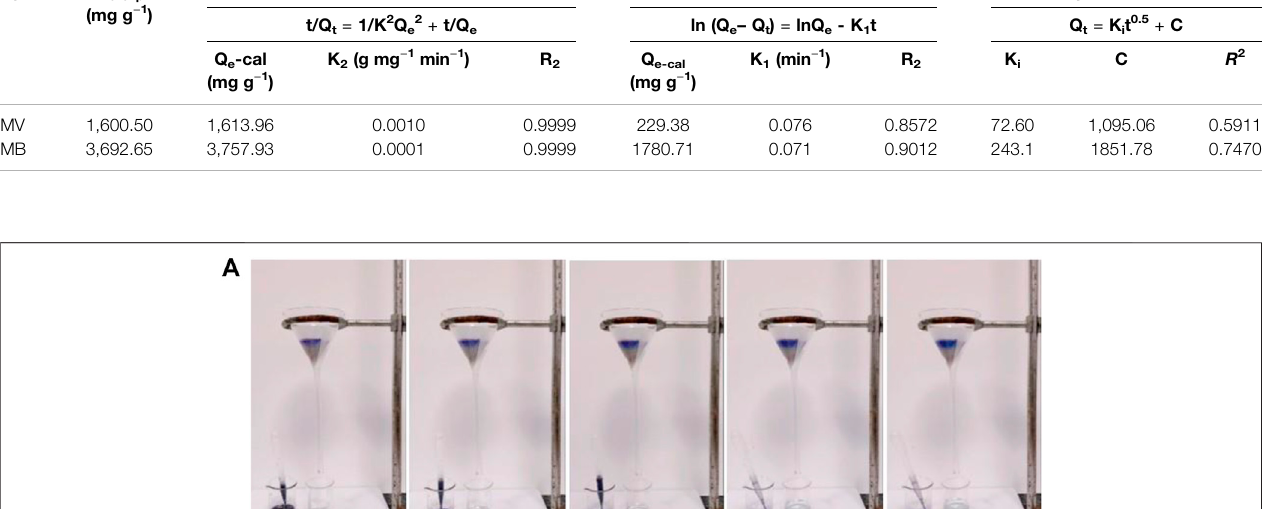
TABLE 2 | Adsorption kinetic parameters of the adsorption of methylene blue (MB) and methyl violet (MV) onto the PFPCS adsorbent at pH (cid:2) 8 and 25 ° C. The initial concentrations of MB and MV were 500 and 1,000 mg L − 1 , respectively, and the contact time is 60 min. Dye